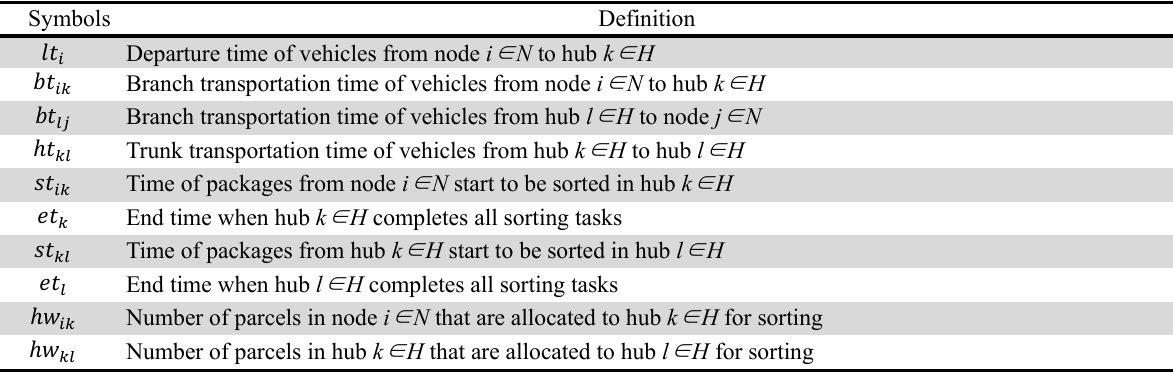
Table 2 shows the notation used to formulate the arrival time function.